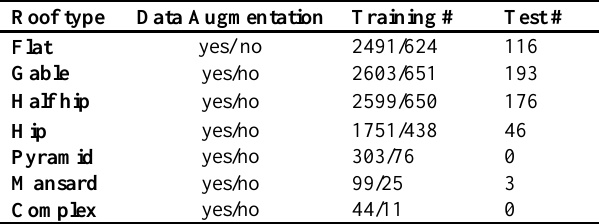
Table 1. The distribution of the training and test sets used in the